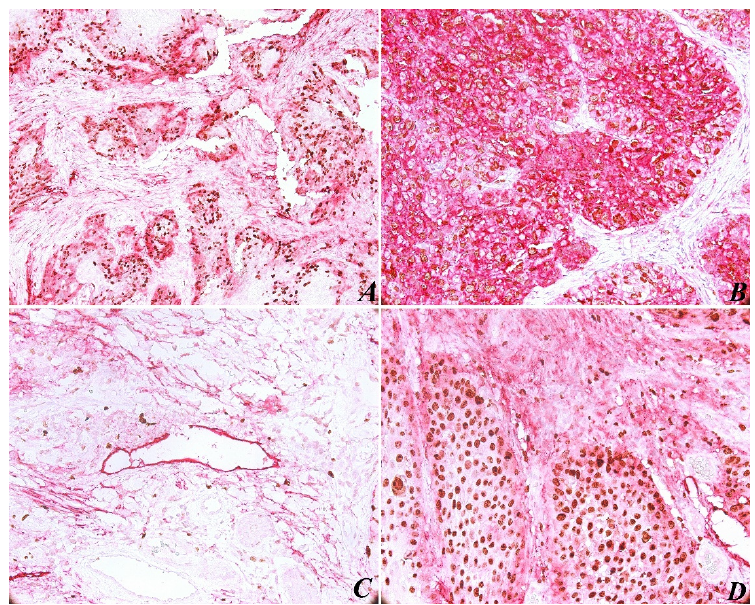
Figure 1. Head and neck squamous cell carcinoma specimens stained with the double immunostaining Ki-67 and podoplanin (purple for podoplanin and brownish for Ki67). High reactivity of podoplanin was present at the periphery of tumor areas, score +2, original magnification × 200 ( A ). Height expression of podoplanin score +3 and Ki-67 score +3 in tumor area, original magnification × 200 ( B ). Peritumoral lymphatic vessel with endothelial wall disrupted by tumor cell invasion, original magnification × 200 ( C ). Podoplanin expression at the periphery of tumor and proliferation index Ki-67 score +3, original magnification × 400 ( D ). Table 2. Lymph microvessel density (LMVD) correlation with Broder histological criteria.